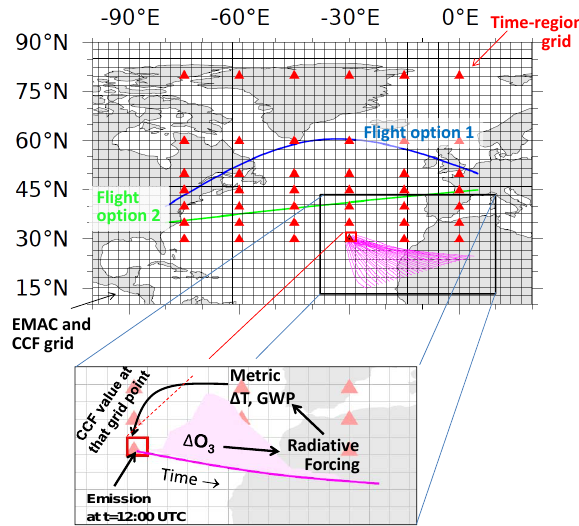
Fig. 3. Latitude–longitude grid of the climate cost function (CCF) and EMAC grid (black) and location of the time-region centres (red triangles). Air parcel trajectories started from the EMAC grid cell in which the time-region grid point is located; these trajectories are given in magenta for one grid point only. Two flight options are shown as examples in blue and green. Inlay: the climate cost func- tion calculation is shown as an example for one air parcel